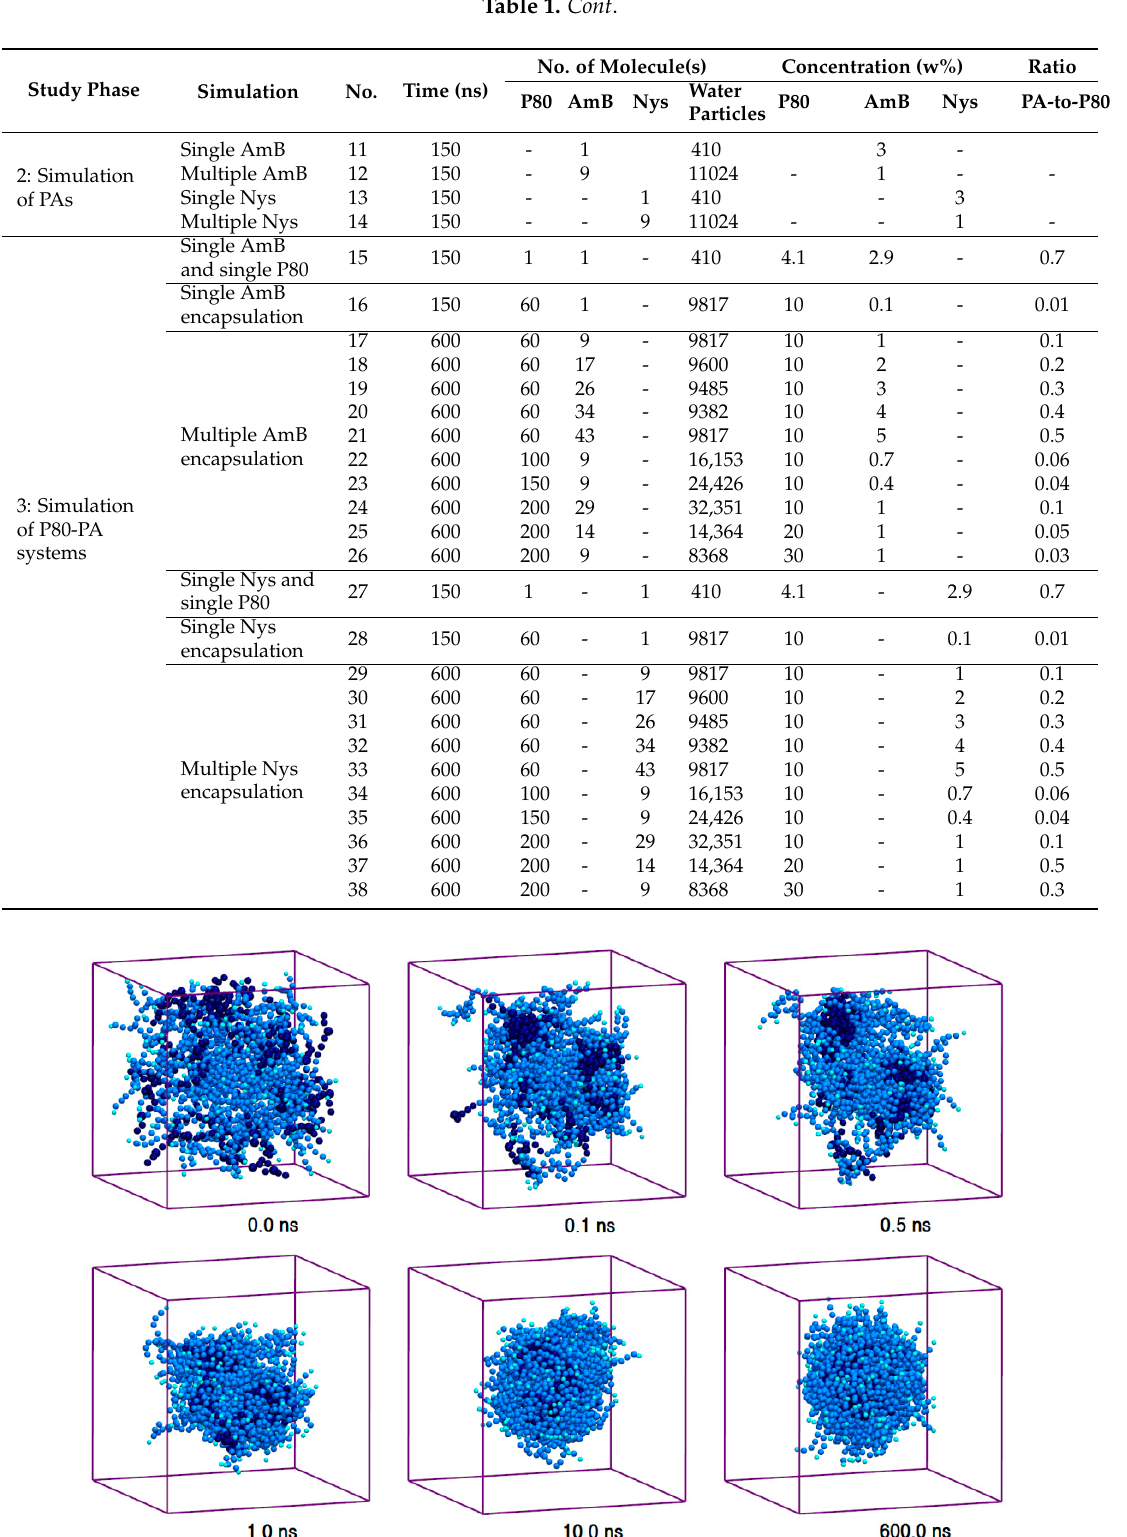
Figure 1. Trajectory snapshots of micellation of Polysorbate 80 (P80) in the aqueous medium at different simulation times (water particles have been removed for clarity).